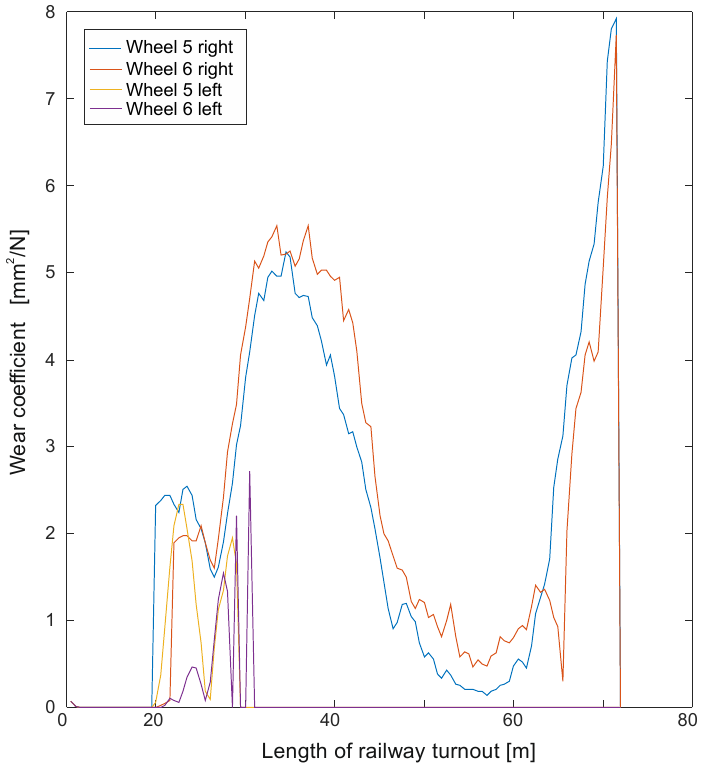
Figure 34. Wear coefficient obtained for a straight track at 300 km/h with a turnout.